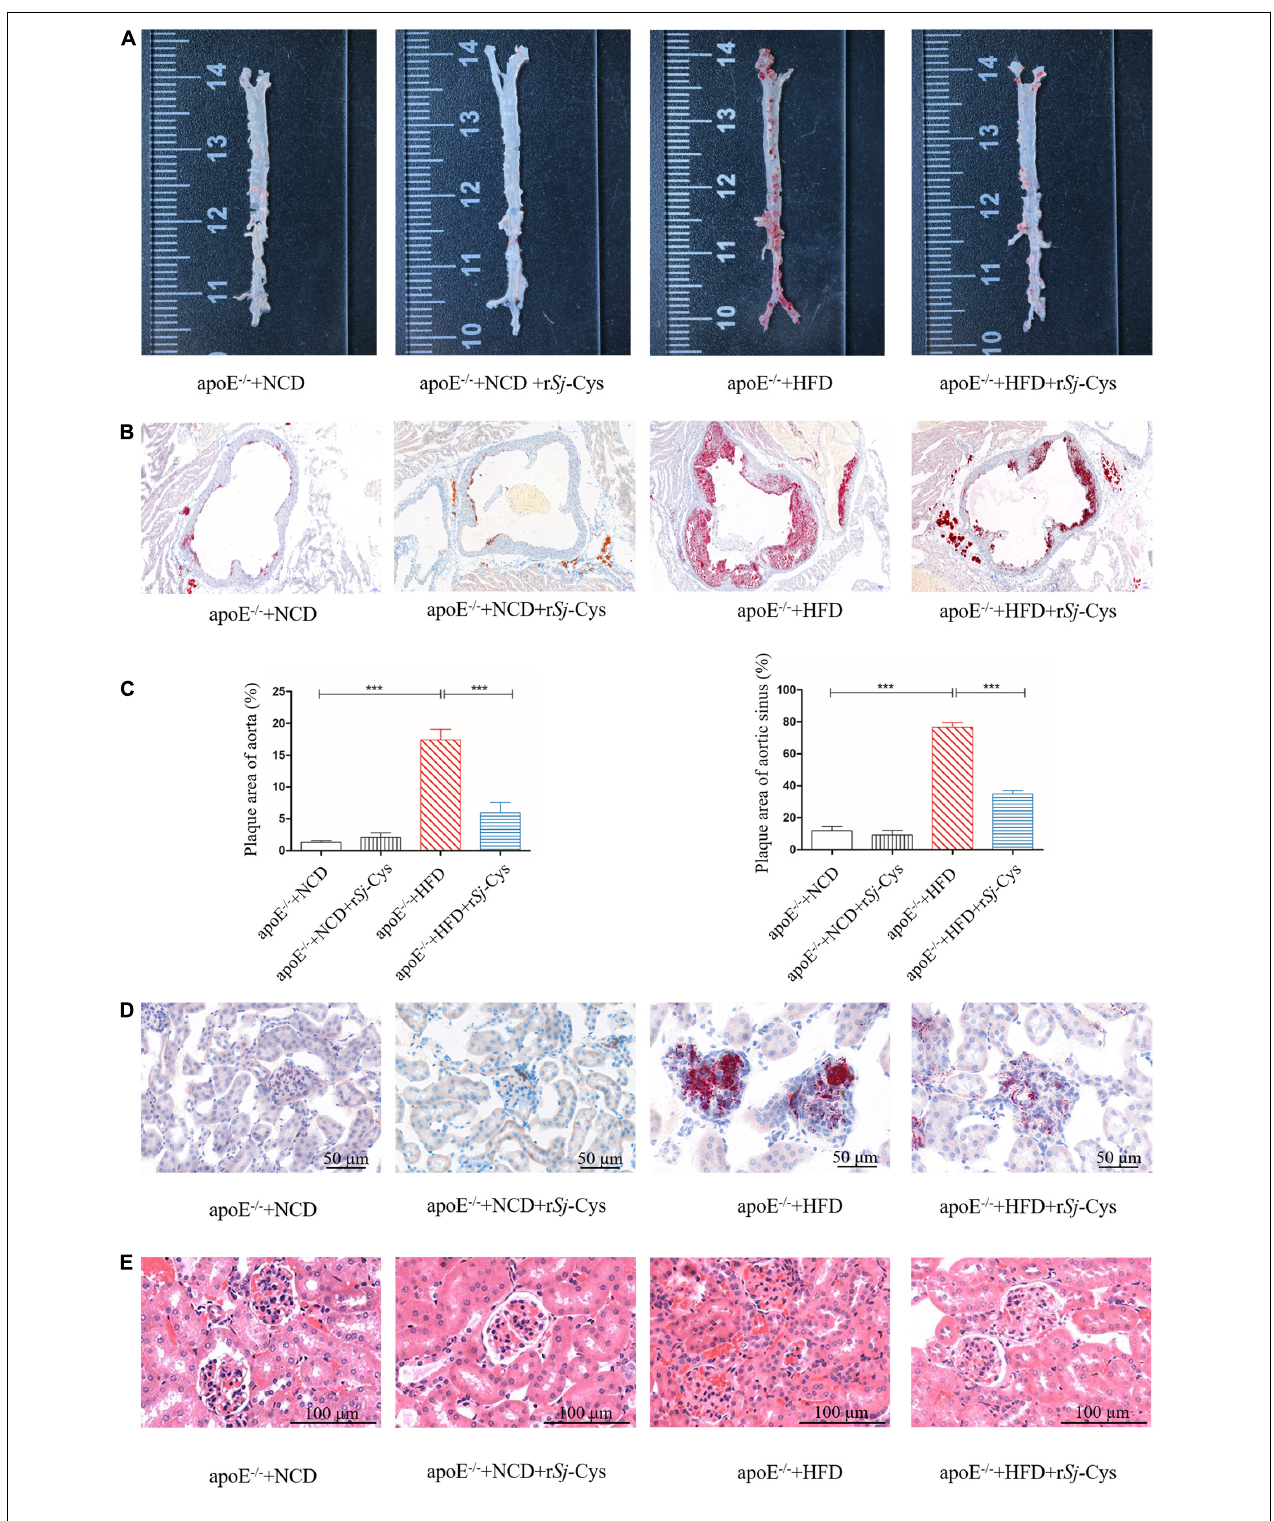
FIGURE 3 | r Sj -Cys reduced the development of atherosclerosis. (A) Representative oil red O staining of aorta. (B) Representative oil red O staining of the aortic sinus. (C) The plaque area quantified as a percentage of the whole area. (D) r Sj -Cys treatment reduced glomerular fat deposition ( × 200, scale bar 50 µ m). (E) Representative HE staining of the renal tissue sections ( × 200, scale bar 100 µ m). The data are shown as the mean ± SEM for each group ( n = 6 per group). *** P < 0.001.